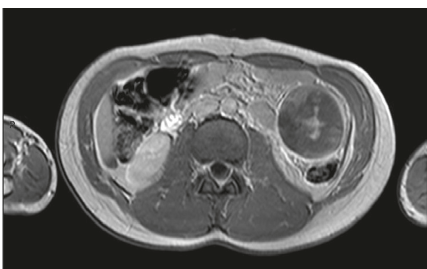
Figure 2: T1-weighted gadolinium-enhanced axial view of MRI showing hemorrhage within the AS.